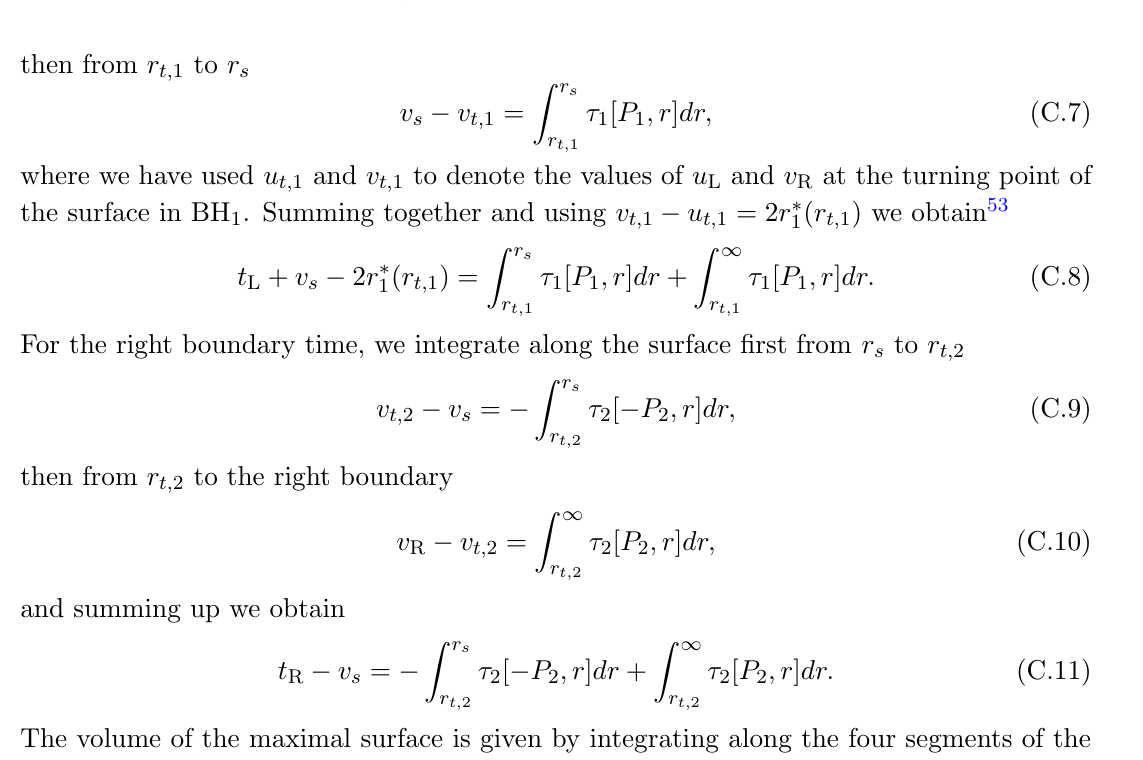
Figure 34. Di(cid:11)erent possibilities for the shape of the maximal surface depending on whether it admits a turning point in BH 1 and/or in BH 2